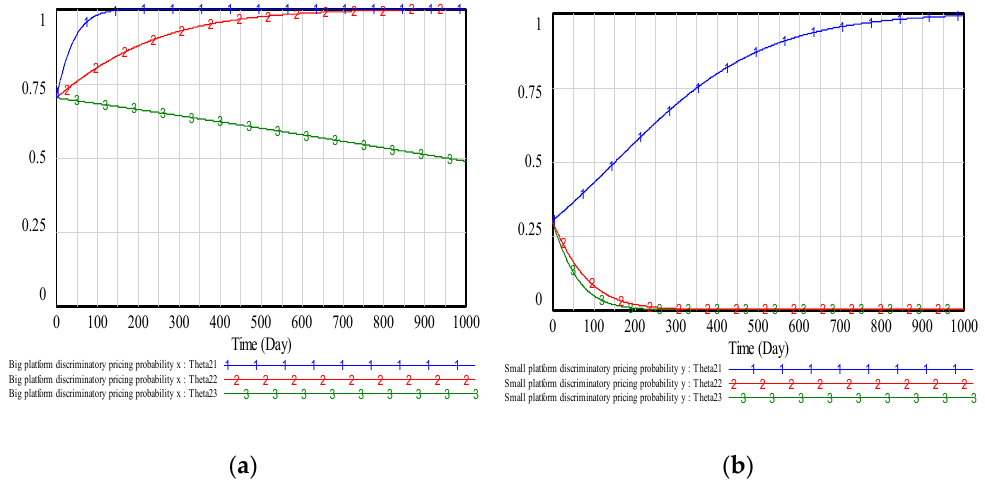
θ . ( a ) The impact of θ on the 2 2 θ on the small platform dis- 2